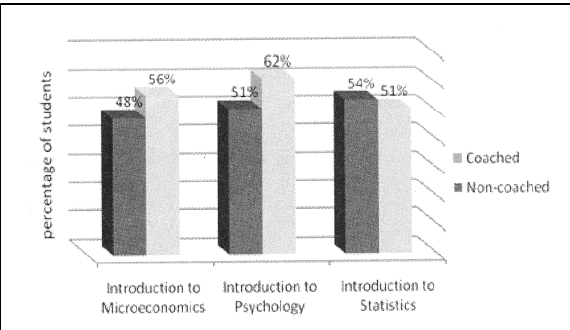
Figure 5. Percentage of students passed the